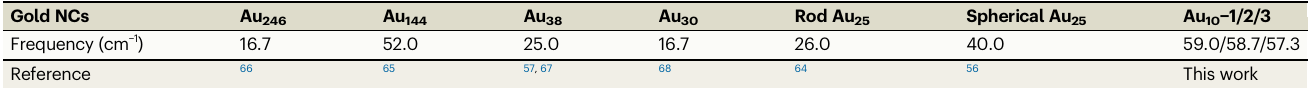
Table 2 | The experimentally reported frequency of coherent oscillations in molecular-like metal